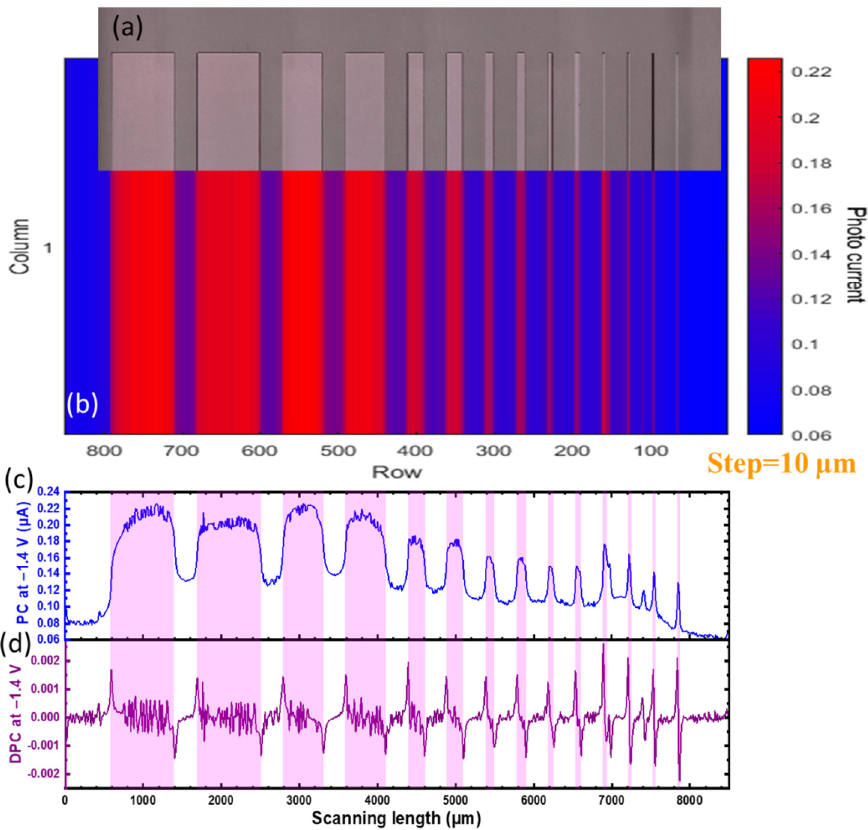
Figure 4. ( a ) Image from an optical microscope, ( b ) image generated from the LabVIEW interface by collecting photocurrents and coordinates, ( c ) photocurrent and ( d ) differential photocurrent versus its Y coordinates with a DC bias at −1.4 V and illumination with a trigger current of 0.025 A and AC frequency at 1000 Hz in line scanning with a step spacing of 10 μm controlled by an X-Y stage.